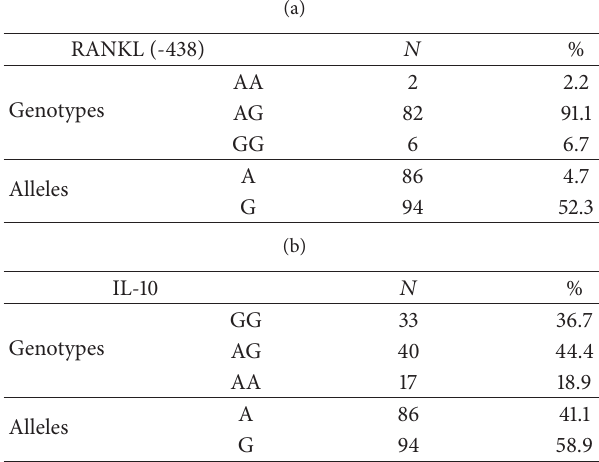
Table 1: Distribution of genotypes and alleles of the studied